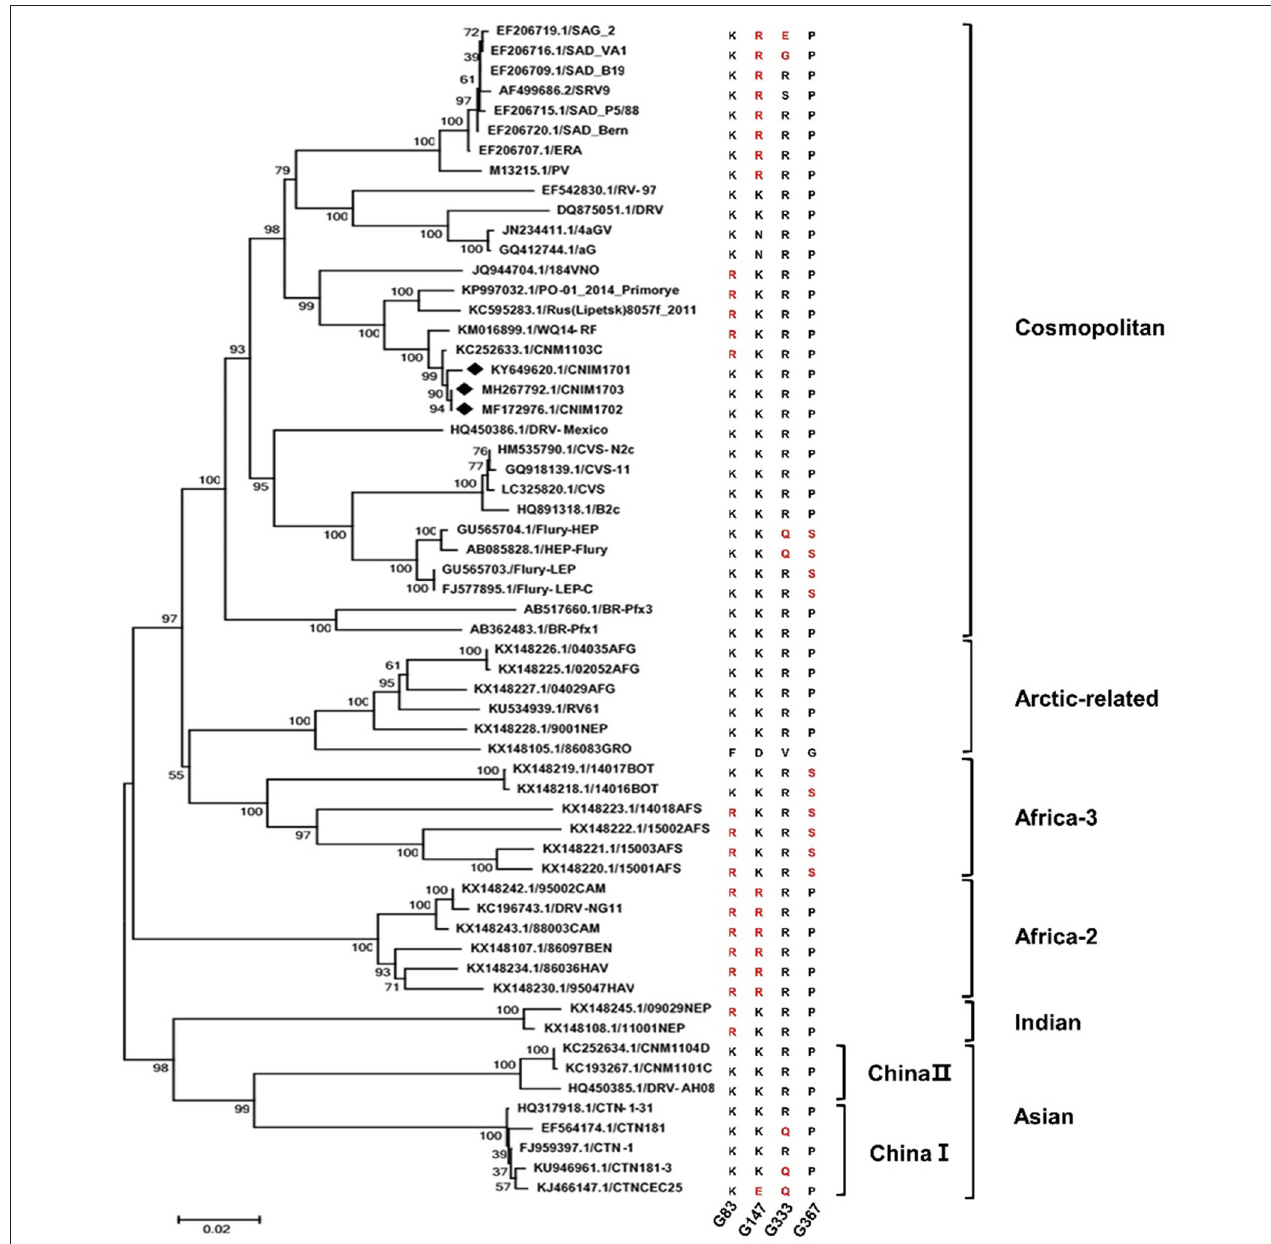
FIGURE 3 | Phylogenetic analysis of the complete genome sequence of CNIM 1701 with other RABV strains. The tree was constructed using the NJ algorithm in MEGA 7.0 software. The numbers below the branches are bootstrap values for 1,000 replicates. CNIM1701, CNIM1702, and CNIM1703 were marked with a black diamond. Alignment of AA sequences of G with all these 59 RABVs. The arginine (R) is shown in red at G83 and G147. The glutamine (Q) and glutamic acid (E) are shown in red at G333. The serine (S) is shown in red at